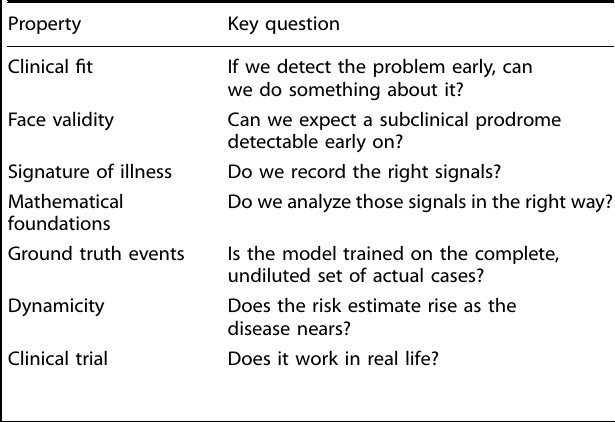
Table 1. Properties and key questions for predictive analytics monitoring research and